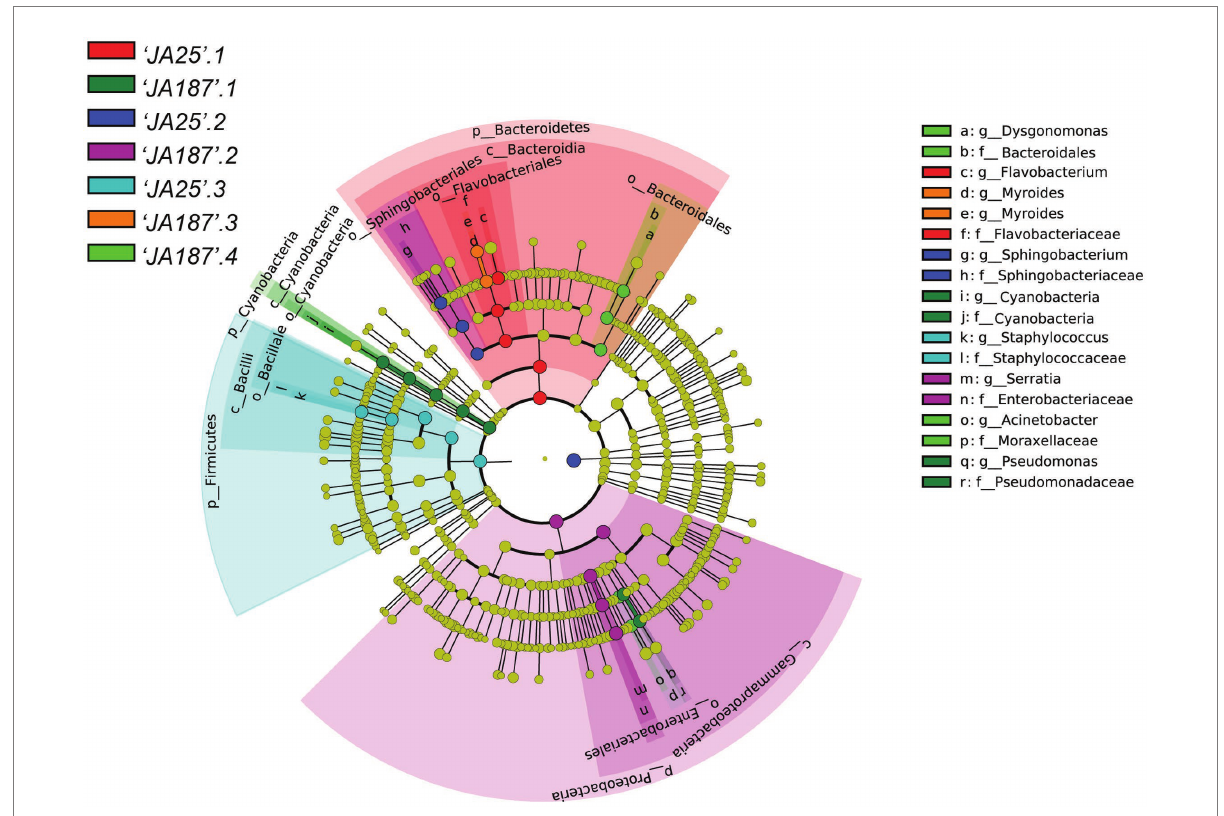
FIGURE 5 Results of LEfSe analysis of bacterial communities on the surface of tubers of different Jerusalem artichoke resources. The circle radiating from the outside to the inside represents the classification level from the phylum to the genus. Species with no significant differences are uniformly colored yellow, and the different species biomarkers follow the color of the